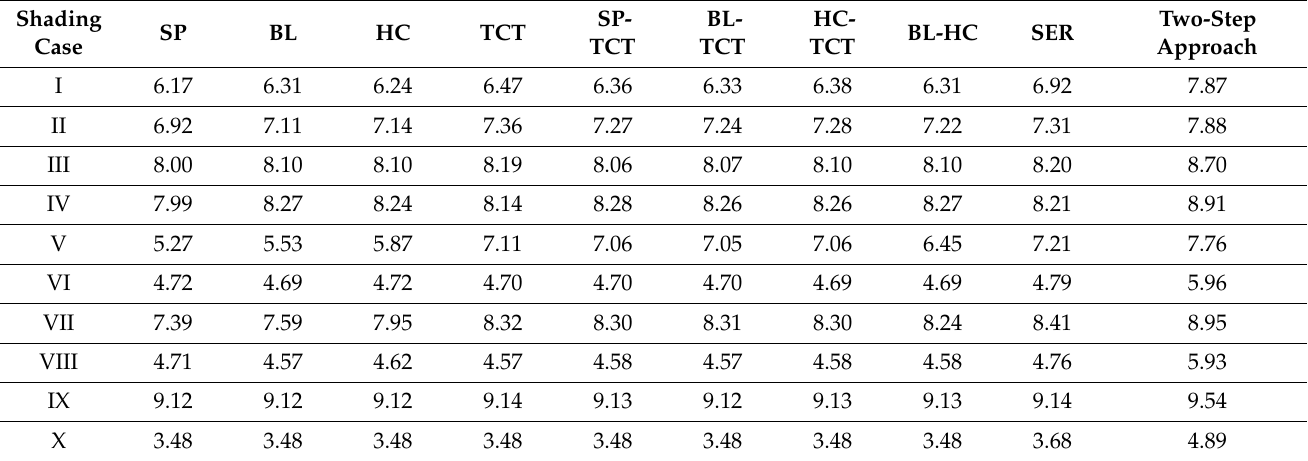
Table 5. Power output of PV array configurations for random shading